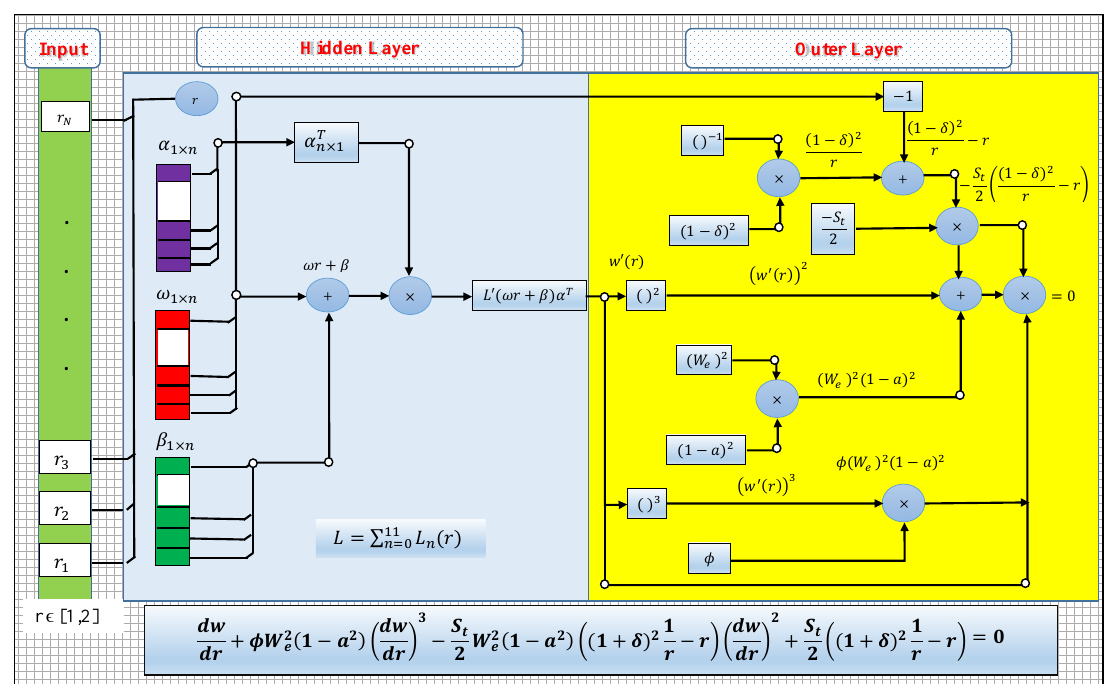
Figure 2. Legendre polynomial based artificial neural networks architecture for drainage